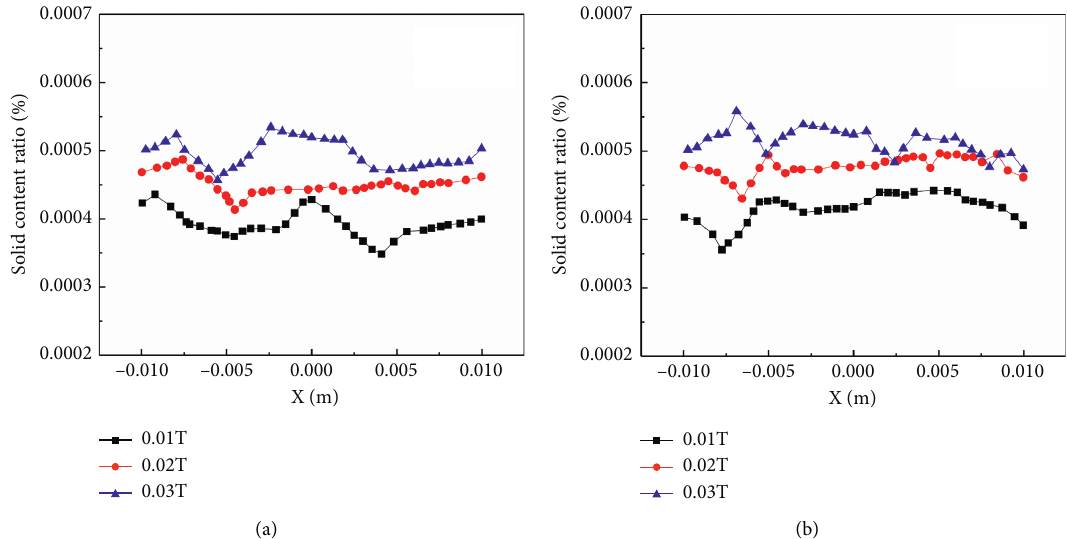
Figure 8: Effect of magnetic field intensity on the distribution of nanomagnetic enzymes. (a) Distribution of solid content at an axial height of 75mm under different magnetic field strength (b) Distribution of solid content at an axial height of 225mm under different magnetic field